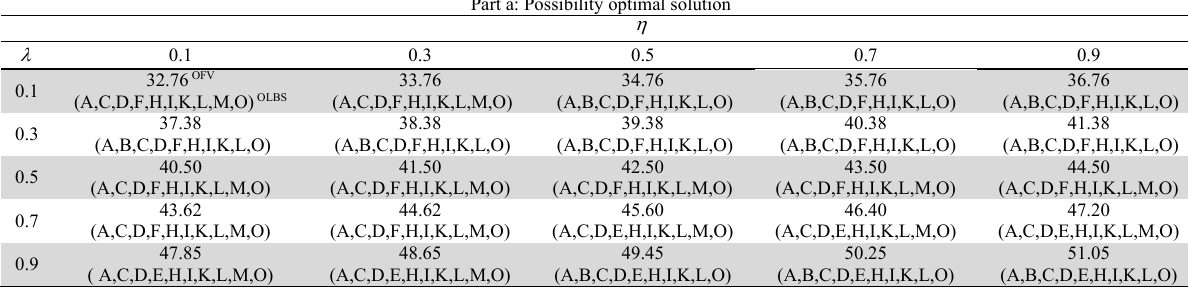
Numerical results of location of the bicycle